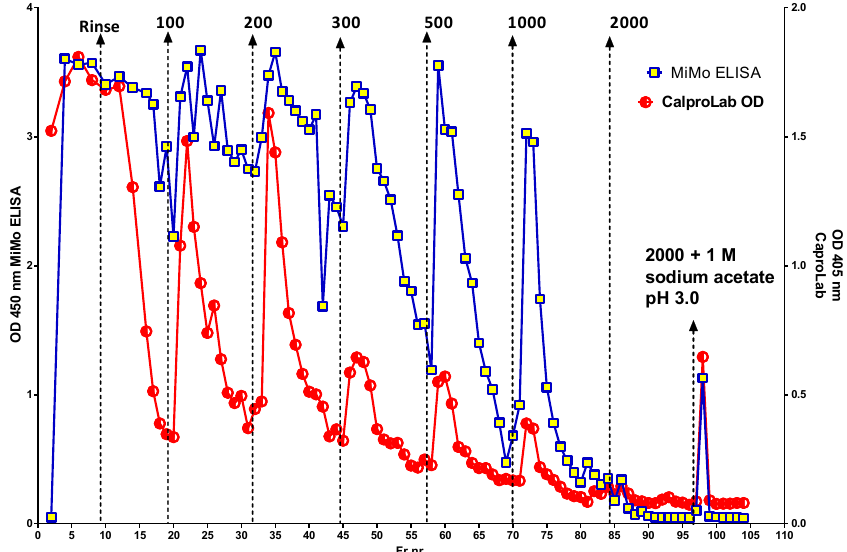
Figure 4. This is a chromatogram from running a fecal extract on the Q-sepharose anion exchange column. Some of the CP did not bind to the column and passed directly through or was washed out with the running buffer. At least five fractions eluted with a stepwise sodium chloride gradient from 100 to 2000 mM or the latter mixed with 1 M sodium acetate pH 3.0. The commercial CalproLab ELISA gave, generally, much lower values, symbols in red/white, than the MiMo ELISA, yellow/blue symbols. In Figure 5 is shown the reactivity of different monoclonals against Q sepharose chromatographic fractions. Clearly, no single monoclonal properly detected all CP subfractions.